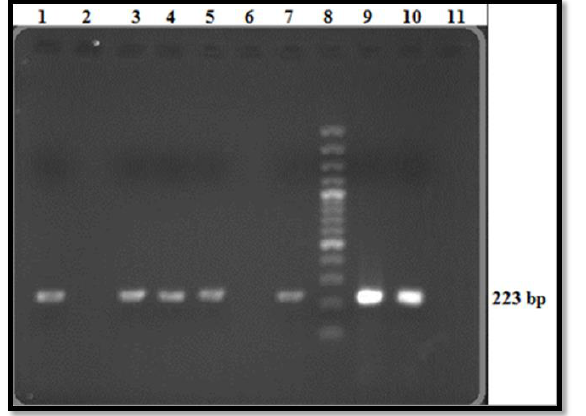
Figure 1. Analysis of PCR products on 2% agarose gel; Lane 1, 3, 4, 5, 7, Positive samples that clearly indicate a 223 bp PCR product; Lane 2, 6, Negative serum samples; Lane 8, 100 bp DNA ladder; Lane 9, 10, Positive controls; Lane 11, Negative control.